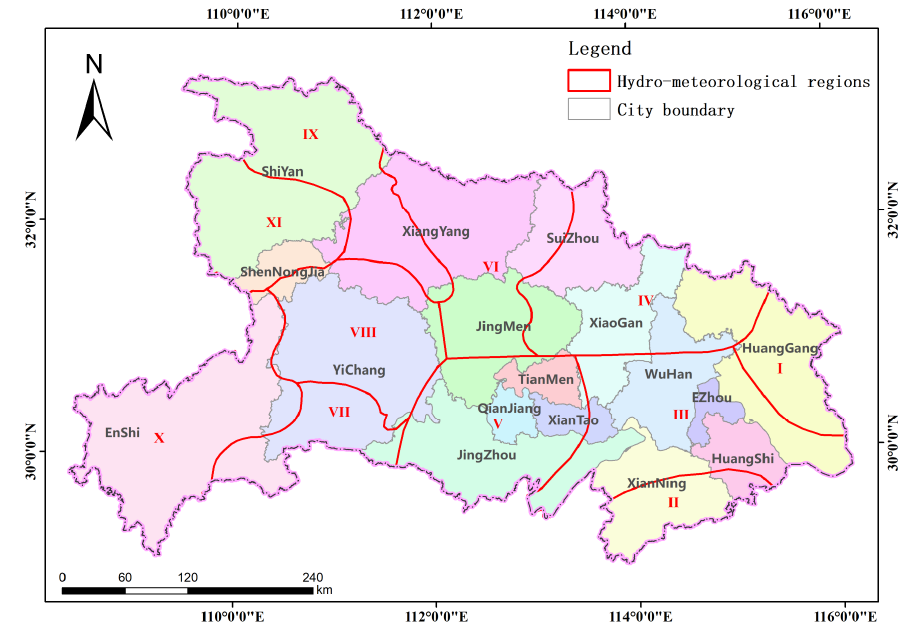
Figure 5. The Hydro-meteorological Regions in Hubei Province.